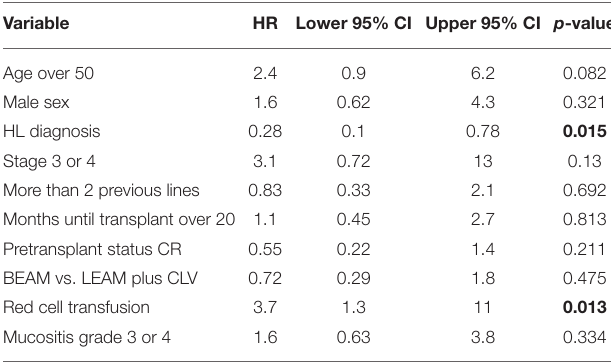
The bold values represent statistically significant values.